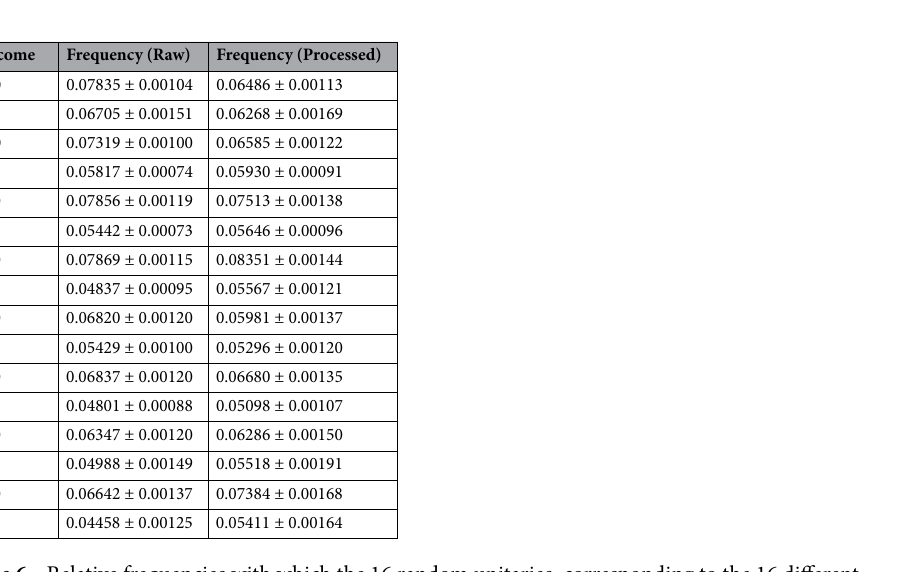
Table 6. Relative frequencies with which the 16 random unitaries, corresponding to the 16 different measurement outcomes, are generated with the approximate 2-design on the ibmq_sydney quantum processor. ‘Raw’ shows the relative frequencies without quantum readout error mitigation. ‘Processed’ shows the relative frequencies with quantum readout error mitigation.